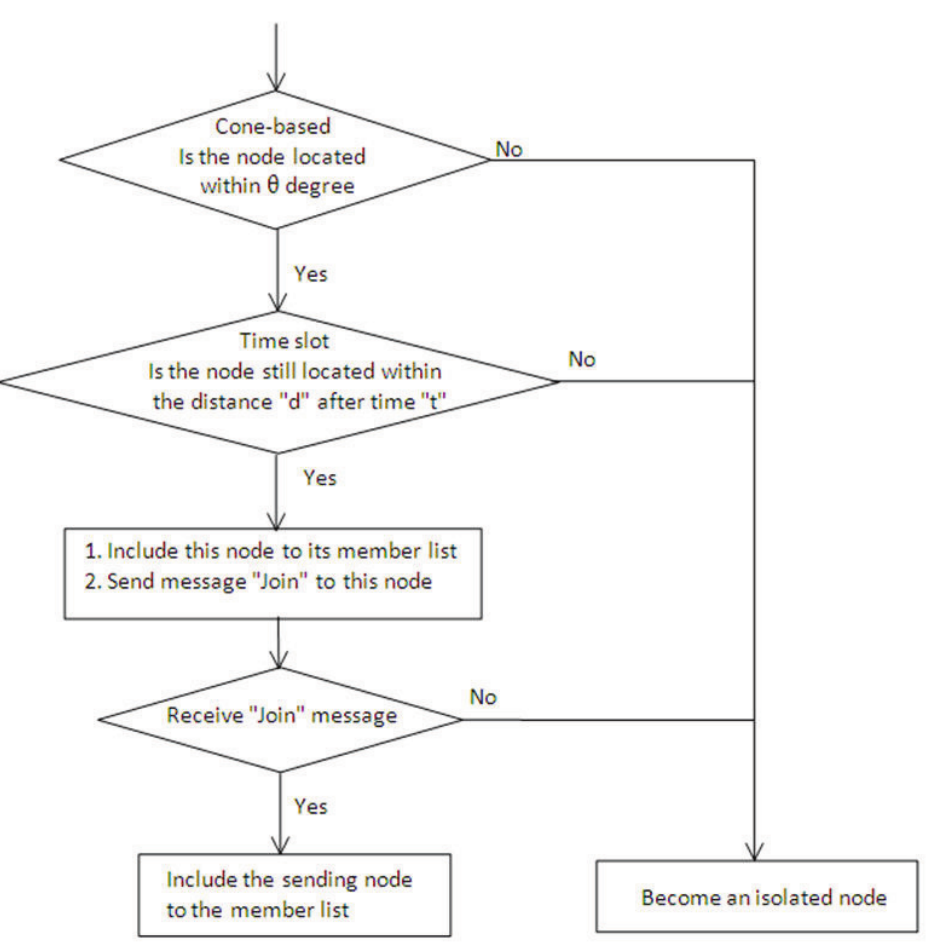
Figure 6. Flow diagram of the HDTC